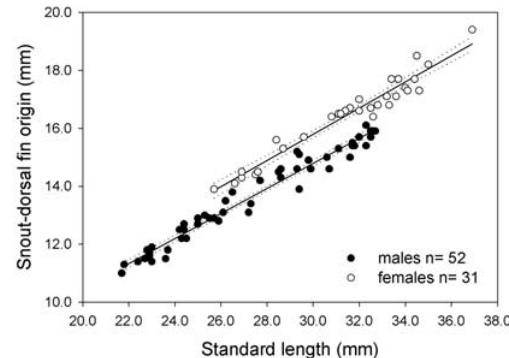
Fig. 9. Snout-dorsal fin origin as a function of standard length for males against females of Odontostilbe pulchra